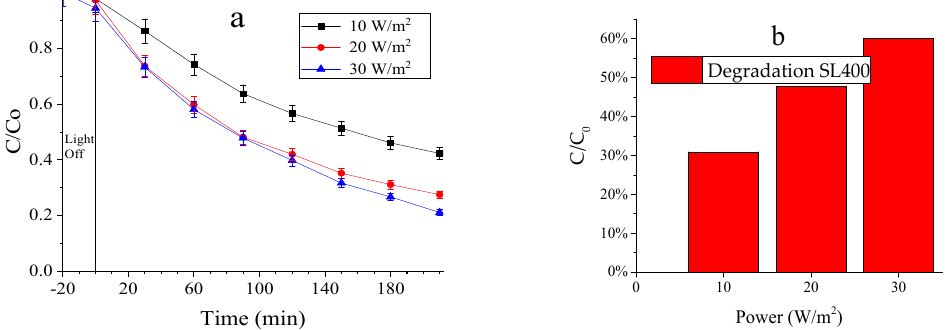
Figure 6. ( a ) Degradation of the cyanocomplex (hexacyanoferrate III) at 10 W, 20 W and 30 W; ( b ) Total removal of dissolved iron. Operating conditions: Initial concentration of K 3 [Fe(CN) 6 ] of 100 ppm, catalyst load of 0.5 g/L, 20 min of adsorption, air flow of 0.5 L/min, reaction time of 3.5 h.